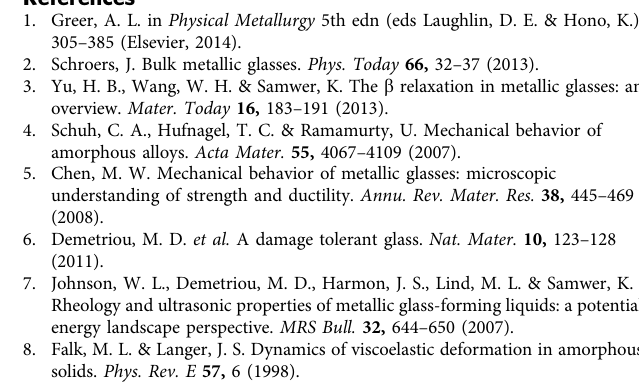
Table 1, using optimized embedded atom method potentials, as performed in our recent publications 40–43 and Kob-Andersen LJ (Lennard-Jones) potentials 60 . The samples were quenched to room temperature (300K) from equilibrium liquids above the corresponding melting points. The quenching was performed using a Nose- Hoover thermostat with zero external pressure. Periodic boundary conditions were applied in all three directions during MD simulation 59 . Voronoi tessellation analysis was employed to investigate the short-range order and atomic volume ( O a, i ) based on nearest neighbour atoms determined for the MG inherent structure 9 . Calculation of vibrational MSD and vibrational anisotropy . In MD simulation, each sample was kept at equilibrium under a microcanonical ensemble (NVE) at room temperature to calculate the vibrational MSD. The MSD of the i th atom is defined as: x i ð t Þ(cid:3) (cid:2) x i ð